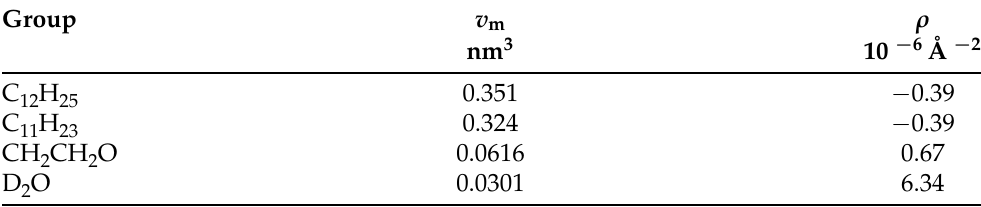
Table A4. Molecular volumes v m are given in [57,84]. Neutron scattering length densities ρ of the surfactants alkyl chains C 11 H 23 and C 12 H 25 , ethylene oxide (EO, CH 2 CH 2 O) contained in the headgroups, and the solvent D 2 O are calculated with the NIST NCNR SLD calculator, knowing